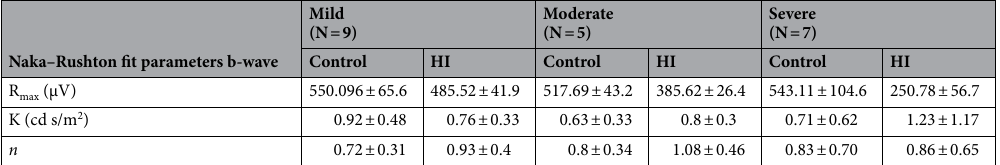
Table 1. Naka–Rushton parameters (means ± SD) for dark-adapted b-wave amplitudes of P30D21 control and HI injured eyes. R max is the maximum response amplitude to a range of flash intensities (I)s given in cd s/m 2 . K is the stimulus intensity ( I ) that produces a response amplitude that is half of R max . n is proportional to the slope of the curve at the point where the contrast is taken to be